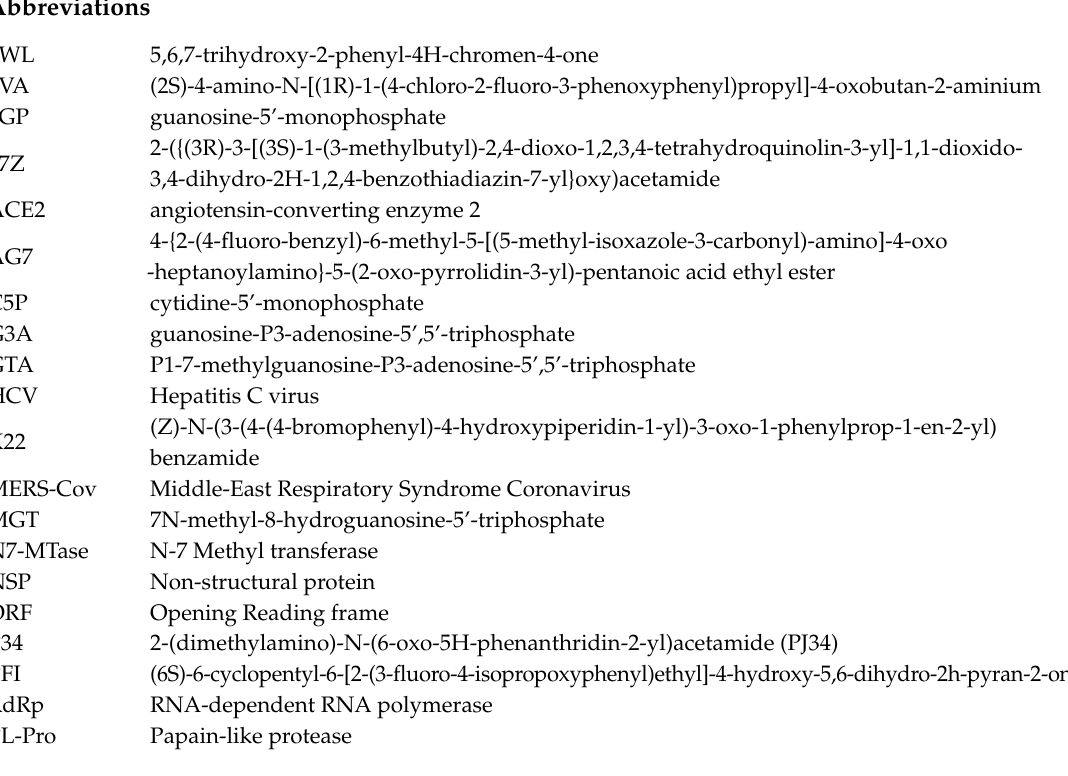
Table S1: Results of the pocket analysis as performed by Pockets 2.0 on the collected GPCR targets. The Pockets 2.0 performances were evaluated by considering its capacity to identify the orthosteric and allosteric sites within the selected GPCR